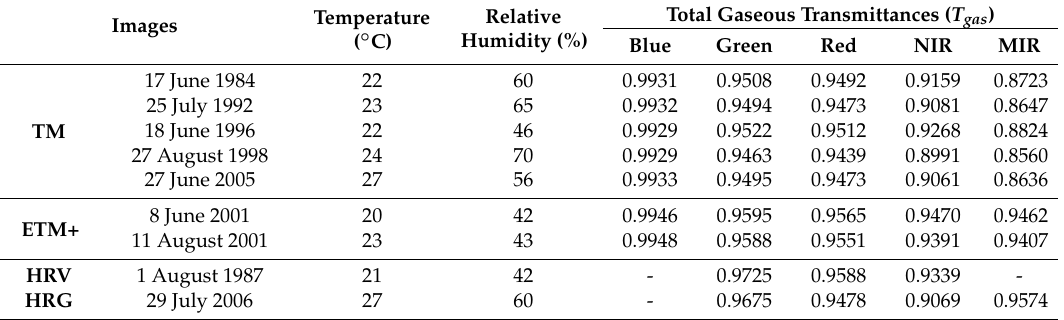
Table 1. Gaseous transmittances calculated for Landsat and SPOT images used for validation. Temperature and relative humidity were used for atmospheric water vapour estimation. MIR: